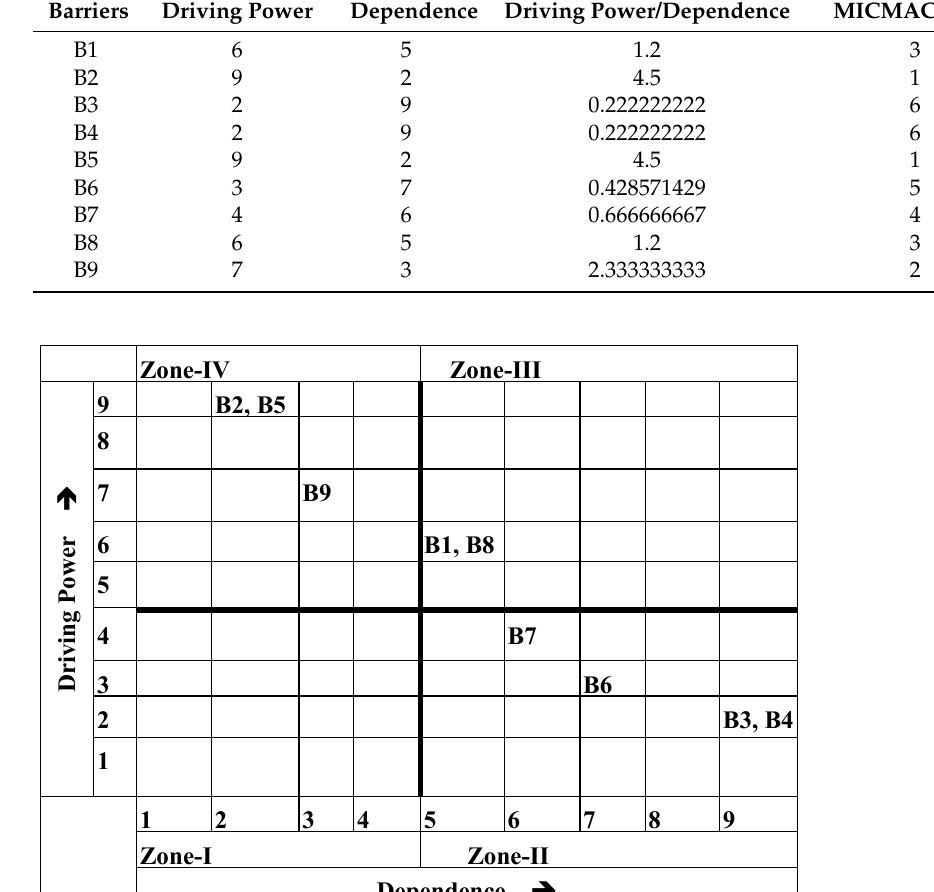
Table 9. Driving power and dependence computation of cross-impact matrix multiplication applied to classification (MICMAC) ranks.